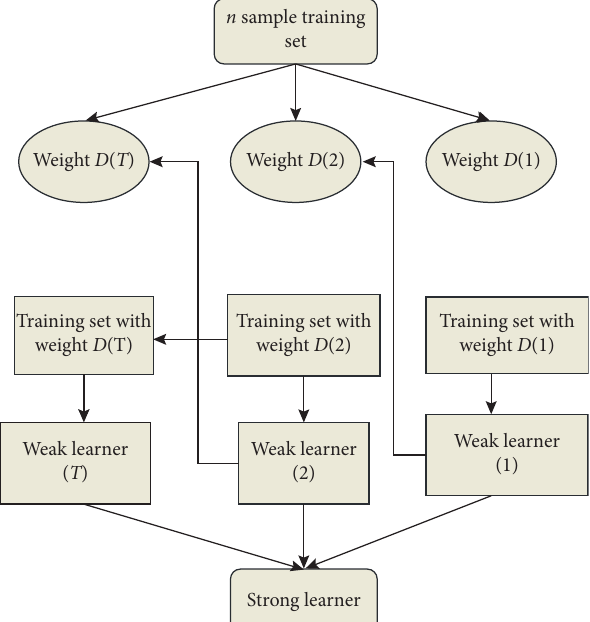
Figure 5: AdaBoost algorithm flow